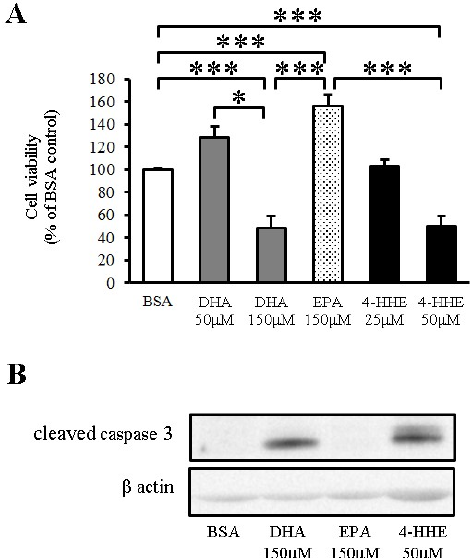
Figure 4. DHA-derived 4-HHE reduces cell viability through apoptosis in VSMCs. ( A ) VSMCs were treated with a high concentration of DHA (150 μ M), EPA (150 μ M) or 4-HHE (50 μ M) for 24 h. Cell viability was determined by the MTT assay. Values are expressed as percentage of cell survival, and each value represents the mean ± SE of five experiments ( n = 15). ( B ) Cleaved caspase-3 and β -actin were determined by Western blotting. DHA (150 μ M), EPA (150 μ M) or 4-HHE (50 μ M) were added for 6 h. * P <0.05, *** P < 0.001,